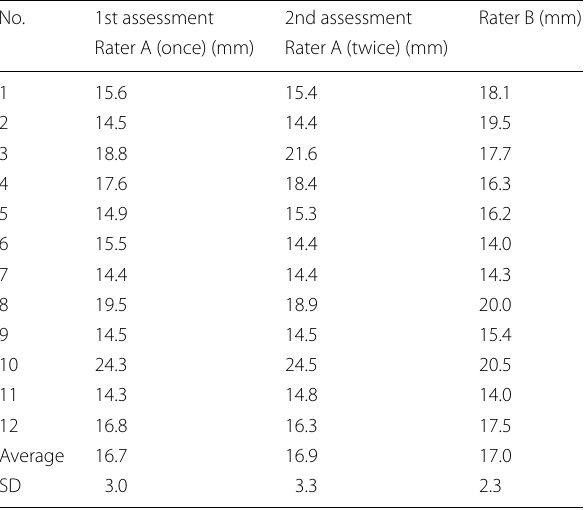
SD standard deviation